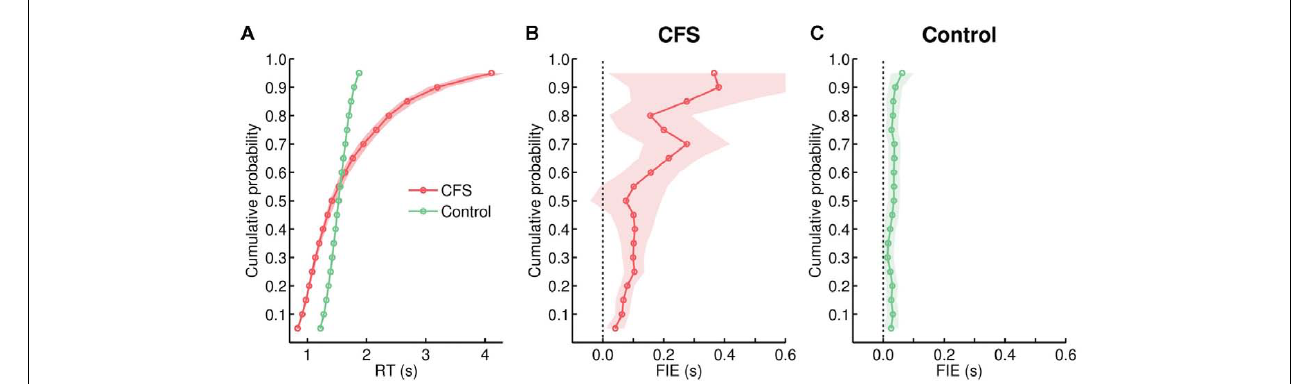
intervals generated by bootstrapping (Mack et al., 2009). (B,C) Size of the FIE as a function of percentiles, plotted separately for the (B) CFS and the (C) control condition.Within each condition, we first created separate group average RT distributions for trials with upright and inverted faces and then computed the FIE (RT inverted–RT upright) at each percentile. In this and all further graphs depicting the FIE at separate percentiles, the shaded areas depict the 95% confidence intervals for the FIE at each